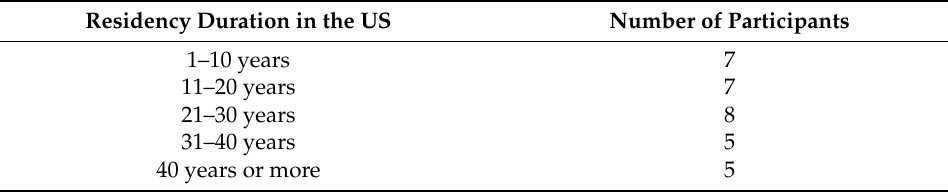
Table 1. Participants’ residency duration in the U.S.